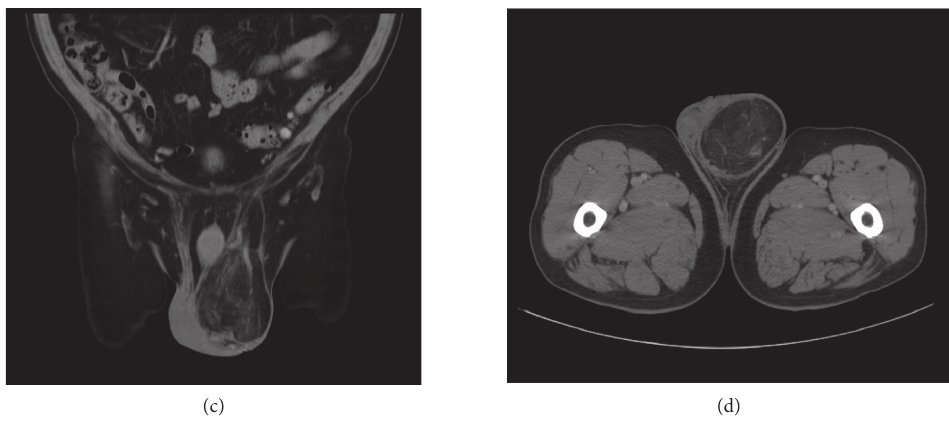
Figure 4: Case example: preoperative imaging comparison of ultrasound and CTscan. The images are of a 72-year-old male who presented with a firm testicular mass with associated scrotal swelling. (a) A scrotal ultrasound shows a mixed echotexture heterogeneous lesion within the left scrotum. Unfortunately, sonographic evaluation of inguinal or scrotal lesions lacks specificity in distinguishing fat- or bowel- containing inguinal hernia from a soft tissue sarcoma, such as a liposarcoma. (b–d) Sagittal, coronal, and axial contrast-enhanced pre- operative CT images in the same patient demonstrate a predominately low-attenuation fatty 10cm mass lesion within the inferior left inguinal canal and left scrotum. The presence of a thickened capsule around the periphery of the lesion as well as prominent enhancing internal septations with nodularity increases suspicion of a well-differentiated